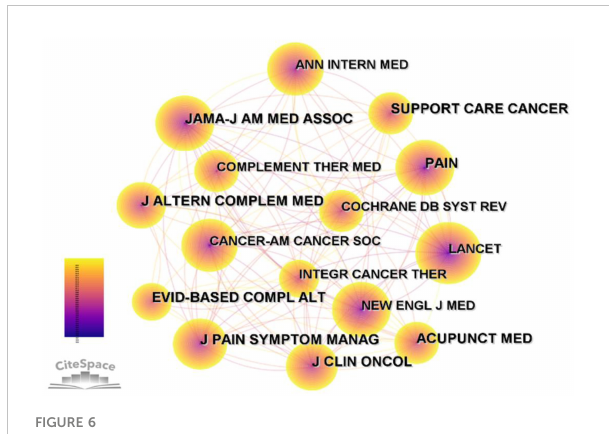
FIGURE 6 Co-citation map of journals related to the research of acupuncture for cancer